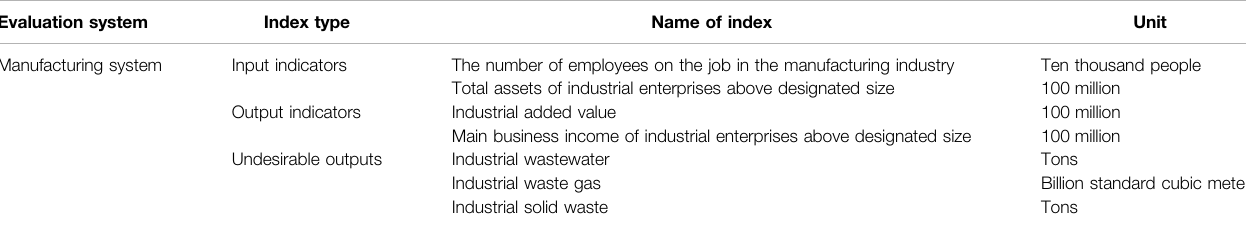
TABLE 1 | Index system of manufacturing industry ecological ef fi ciency.